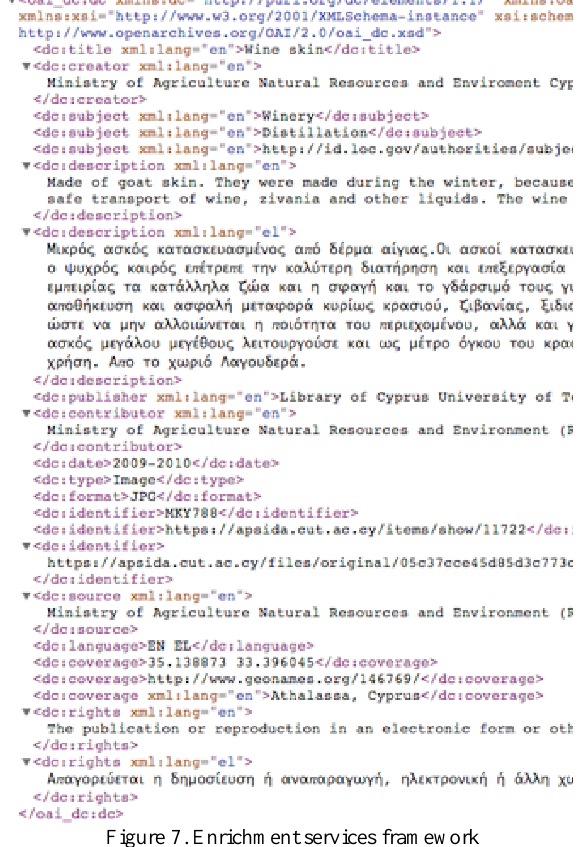
Figure 7. Enrichment services framework